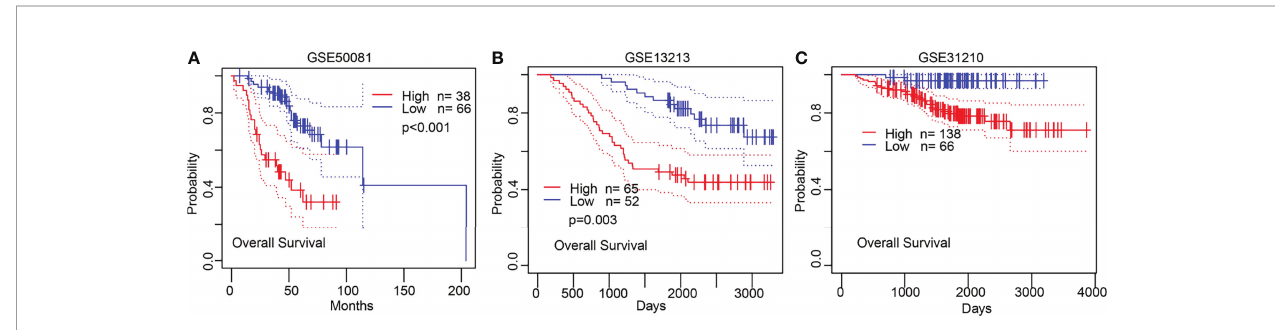
FIGURE 5 | Validation of the prognosis of NCAPG2 in lung cancer. (A – C) Validation of the prognosis of NCAPG2 in lung cancer by GEO dataset.